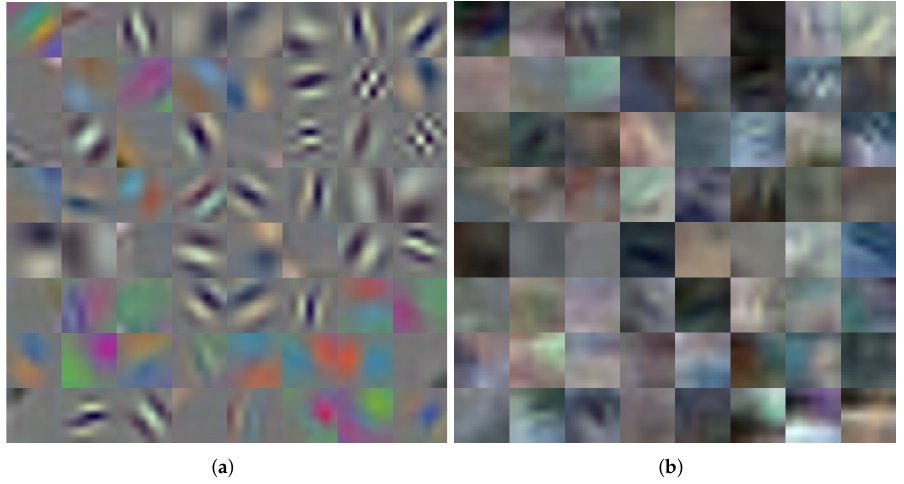
Figure 6. The visualisation of the weight filter from the input convolutional layer in the R-CNN net after training ( a ) and difference with pretrained weight matrix ( b